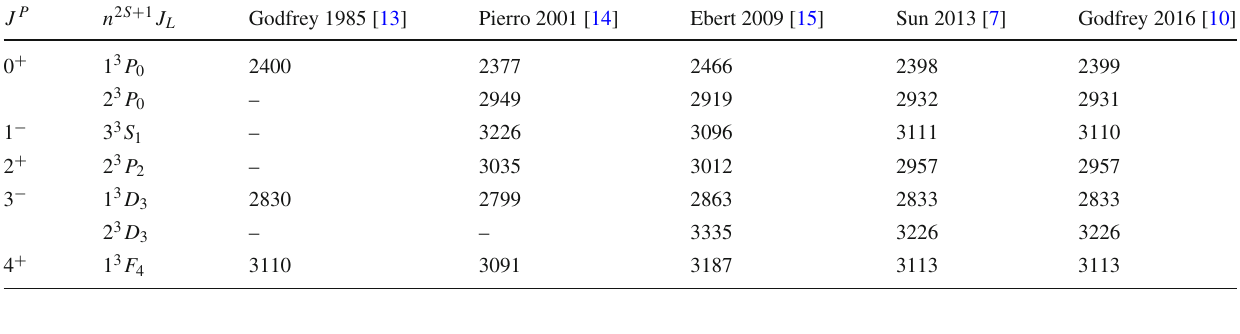
Table 1 Several natural parity candidates of D ∗ J P